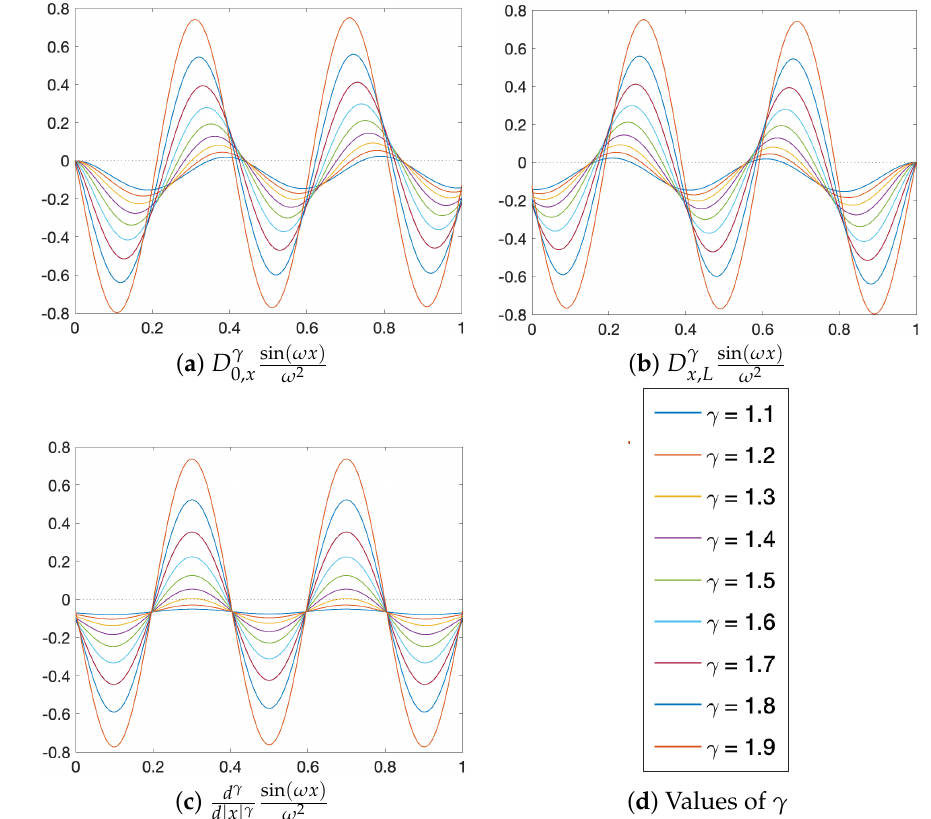
Figure 6. Example 3. The rescaled left (panel ( a )) and right (panel ( b )) Caputo derivatives and the Riesz–Caputo derivative (panel ( c )) of the function y ( x ) = sin ( ω x ) , for different values of γ (panel ( d )) with ω = 5 π